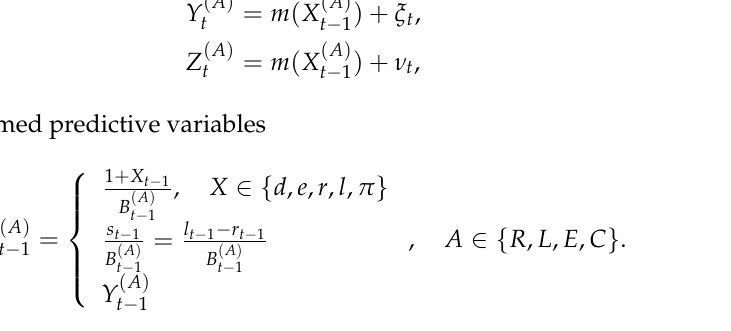
(%) for one-year excess stock returns Y V